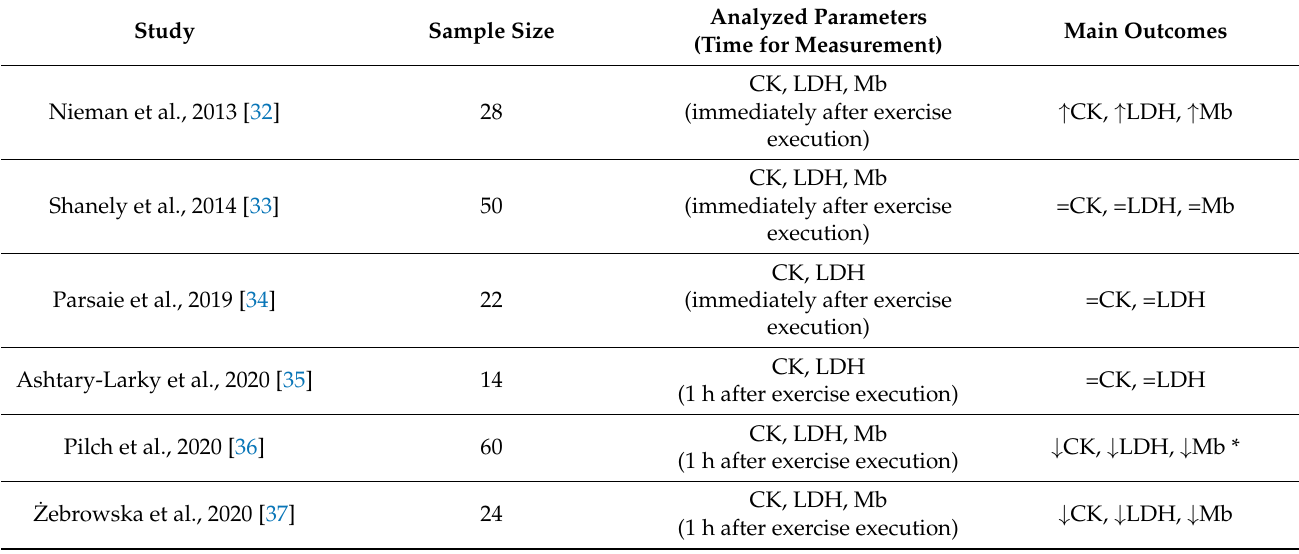
Table 4. Sample size (participants) and main outcomes of the different